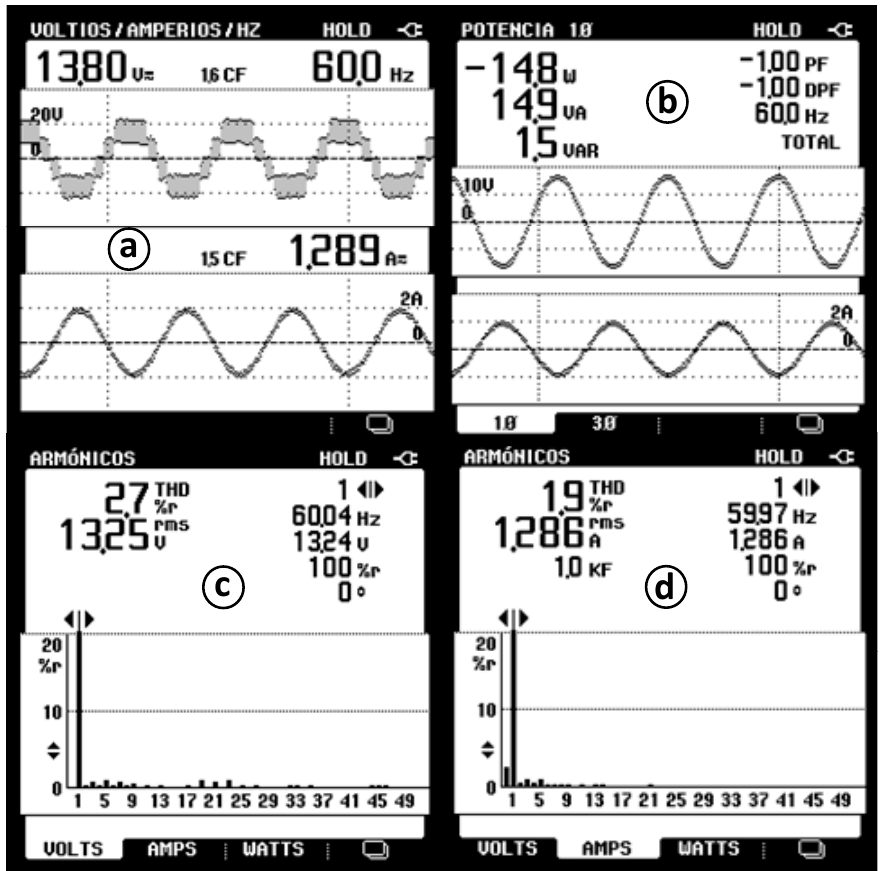
Figure 18. Figure of merit based on the power loss distribution for different five-level NPC converters Figure 17. Fluke 43B-based power quality analysis of grid-tied SPFLC waveforms with the with and without the voltage balancing of the DC-link split capacitors. activation of the DC-link split capacitors’ voltage balancing. ( a ) SPFLC output voltage 𝑉 (cid:3007)(cid:3013)(cid:3004) and the resulting grid current 𝑖 (cid:3034) from the vector control technique; ( b ) grid powers, grid factors, 𝑉 (cid:3034) and 𝑖 (cid:3034) ; ( c ) spectrum of 𝑉 (cid:3007)(cid:3013)(cid:3004) ; and ( d ) spectrum of 𝑖 (cid:3034) .